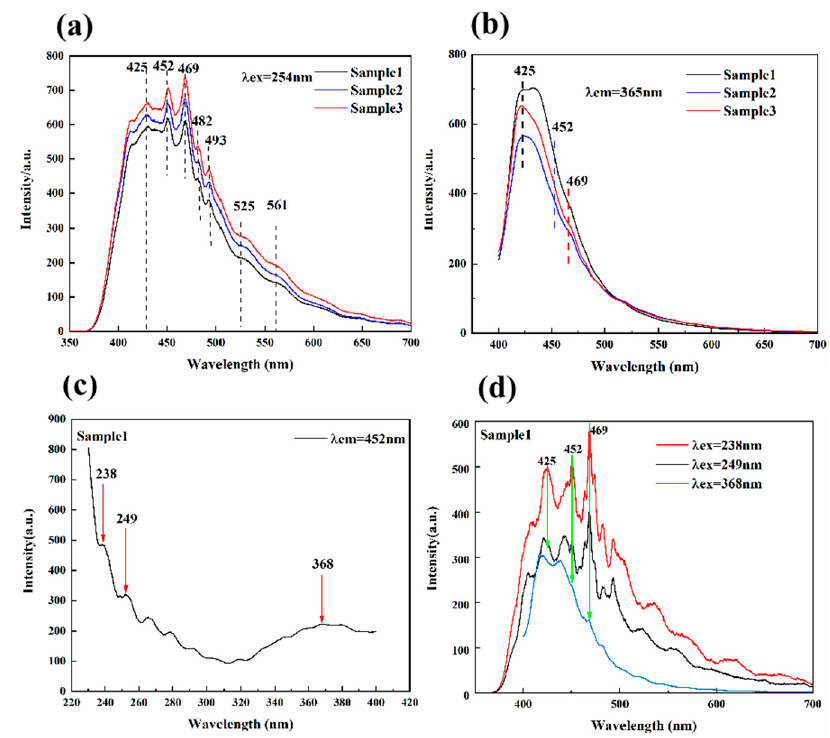
Figure 7. ( a , b ) The photoluminescence emission spectra of the samples ( λ ex = 254, 365 nm). ( c ) The excitation spectrum of sample 1 ( λ em = 452 nm). ( d ) The emission spectrum of sample 1 ( λ ex = 238, 249, 368 nm).